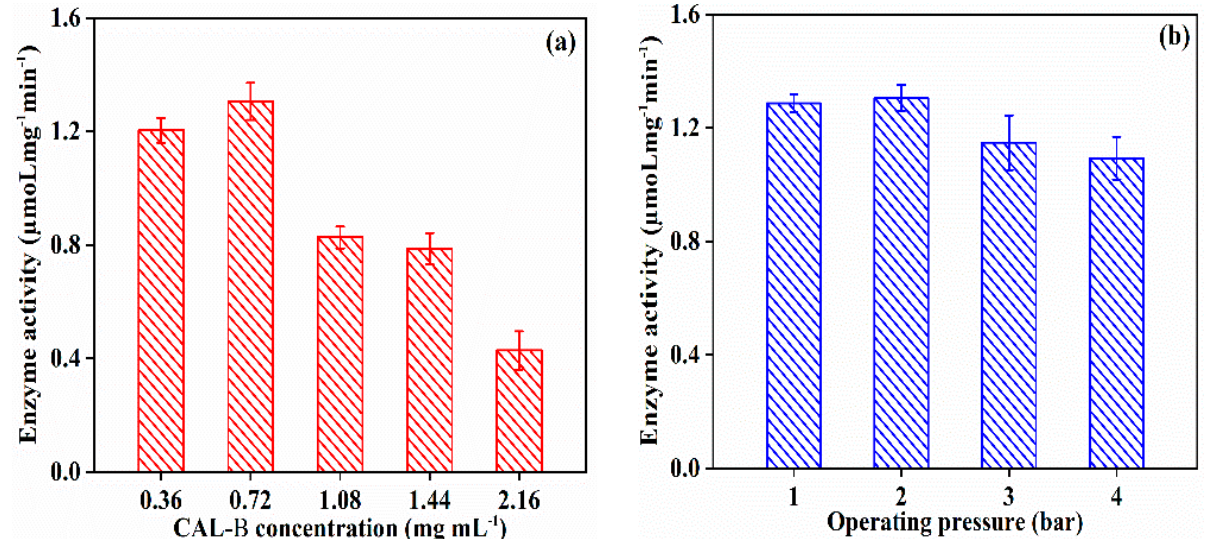
Figure 5. Enzyme activity of CAL-B@PES at different fabrication operating conditions: ( a ) CAL-B concentration, and ( b ) operating pressure .